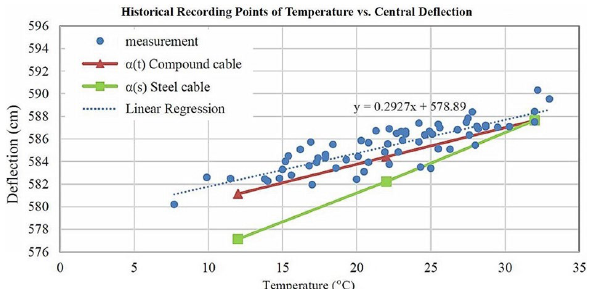
Figure 15. Regression curve of Baishihu suspension bridge main cable deflection with temperature